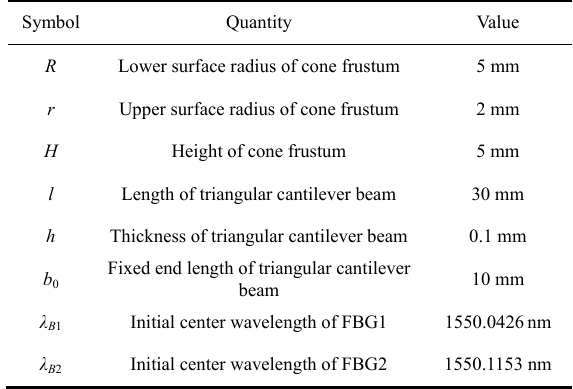
Fig. 4 Prototype of the proposed FBG rotation angle sensor. Table 1 Geometrical and material parameters of the